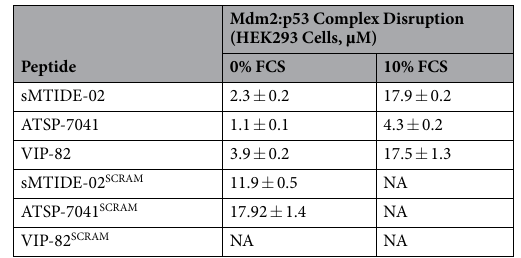
Table 2. NanoBRET IC50 values determined from 4 parameter fits to 10 point titration